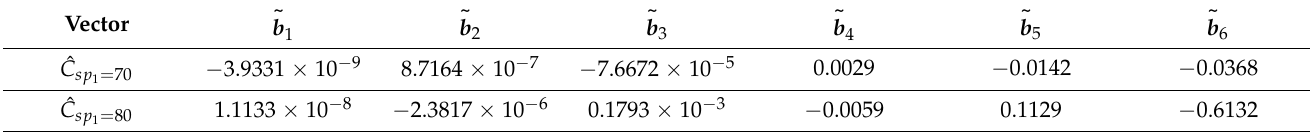
parameters’ values (procedure 1